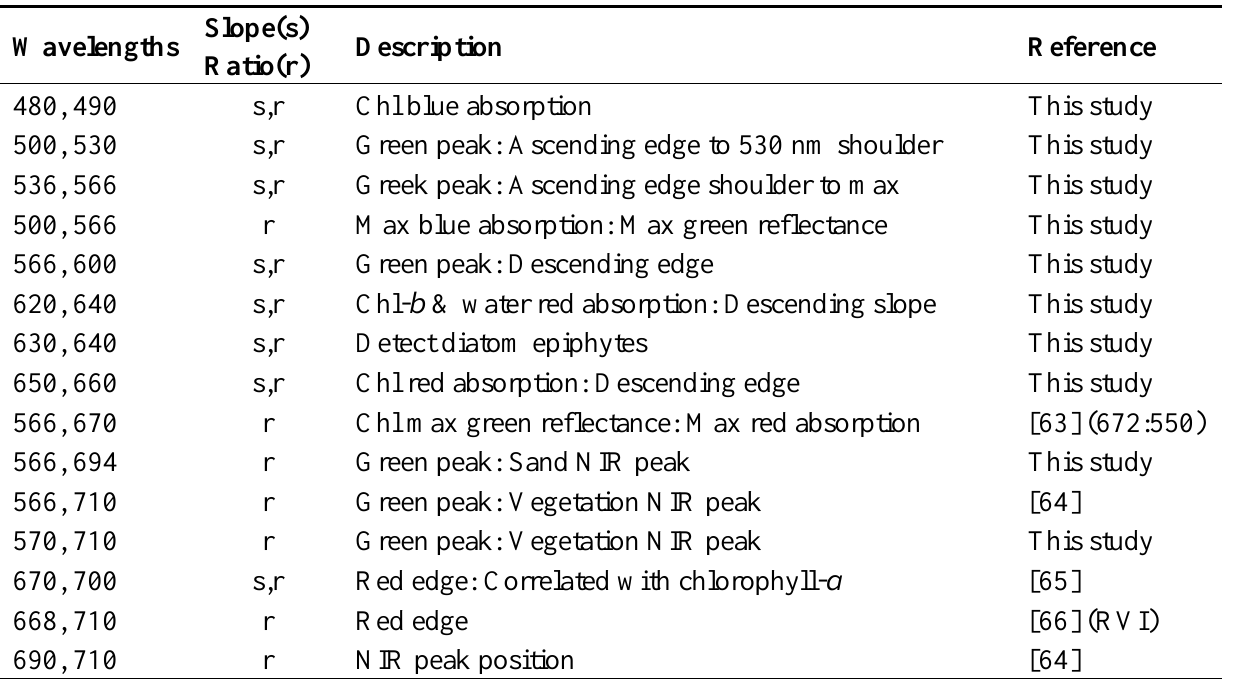
Table 3. List of indices (spectral slopes, denoted s, and ratios, denoted r) defined by visual examination and first derivative